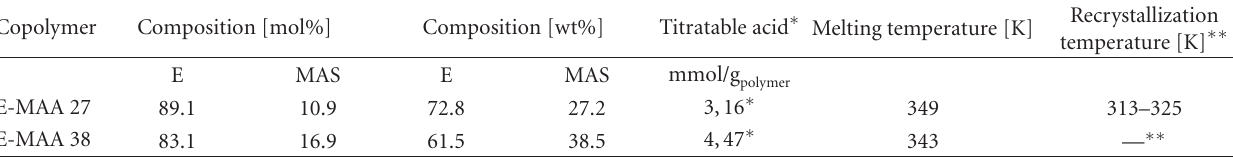
Table 1: Basic copolymers used in this work.